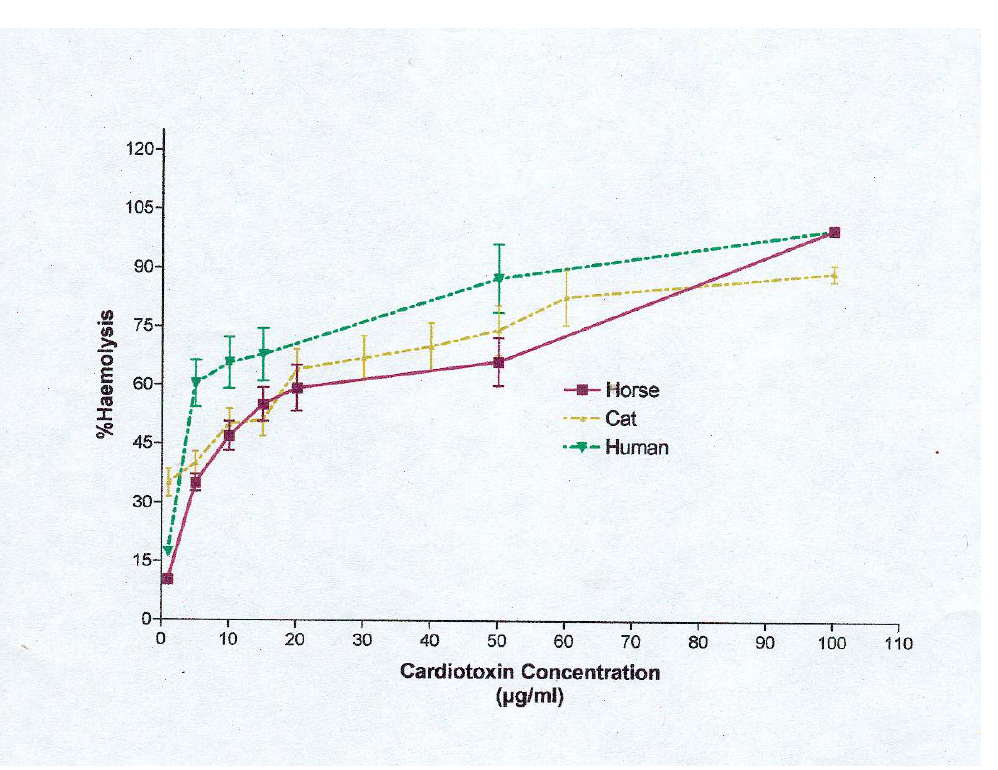
Figure 1. Behavior of human, cat, and horse